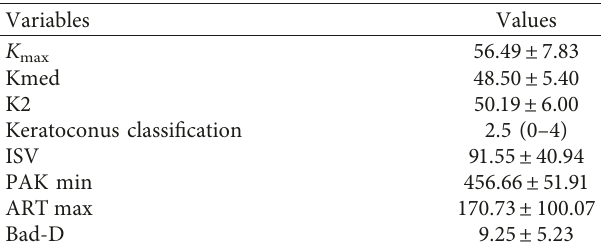
Table 2: Characterization of topographic and pachymetric indices in the keratoconus